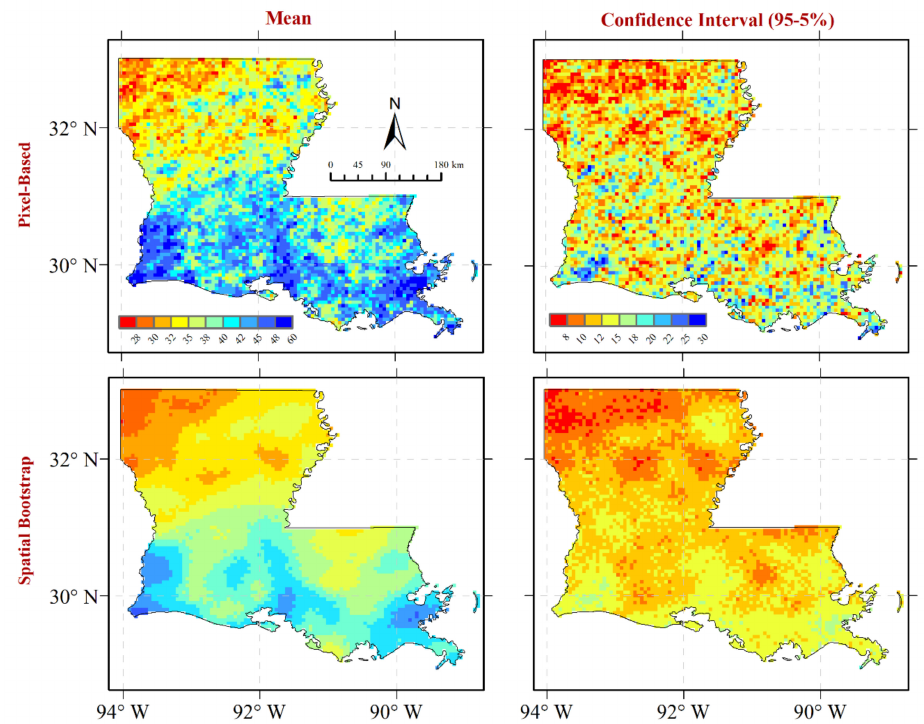
Figure 4. The rainfall depth (in mm) and the confidence width (95–5% percentiles) corresponding to 2-yearreturnperiodfromthepixel-based(upperpanels)andspatialbootstrapapproaches(region-based) (lower panels).